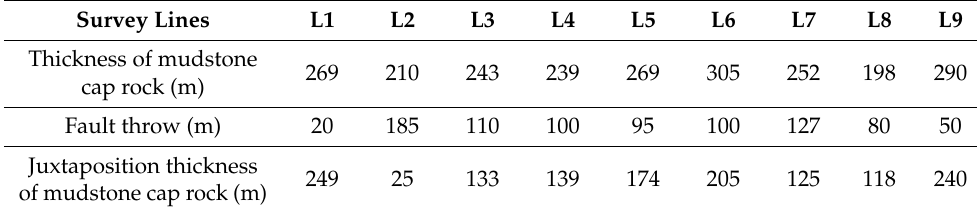
Table 1. Data for the juxtaposition thickness of the mudstone cap rock of E 3 d 2 . Survey